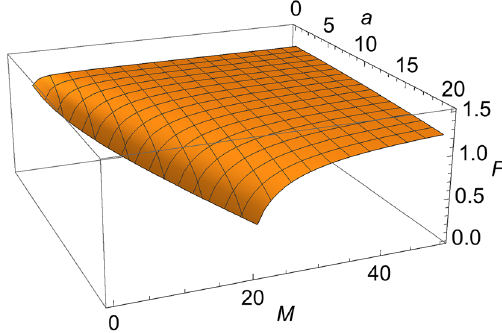
Fig. 1 Plot of M and a versus F ( M , a